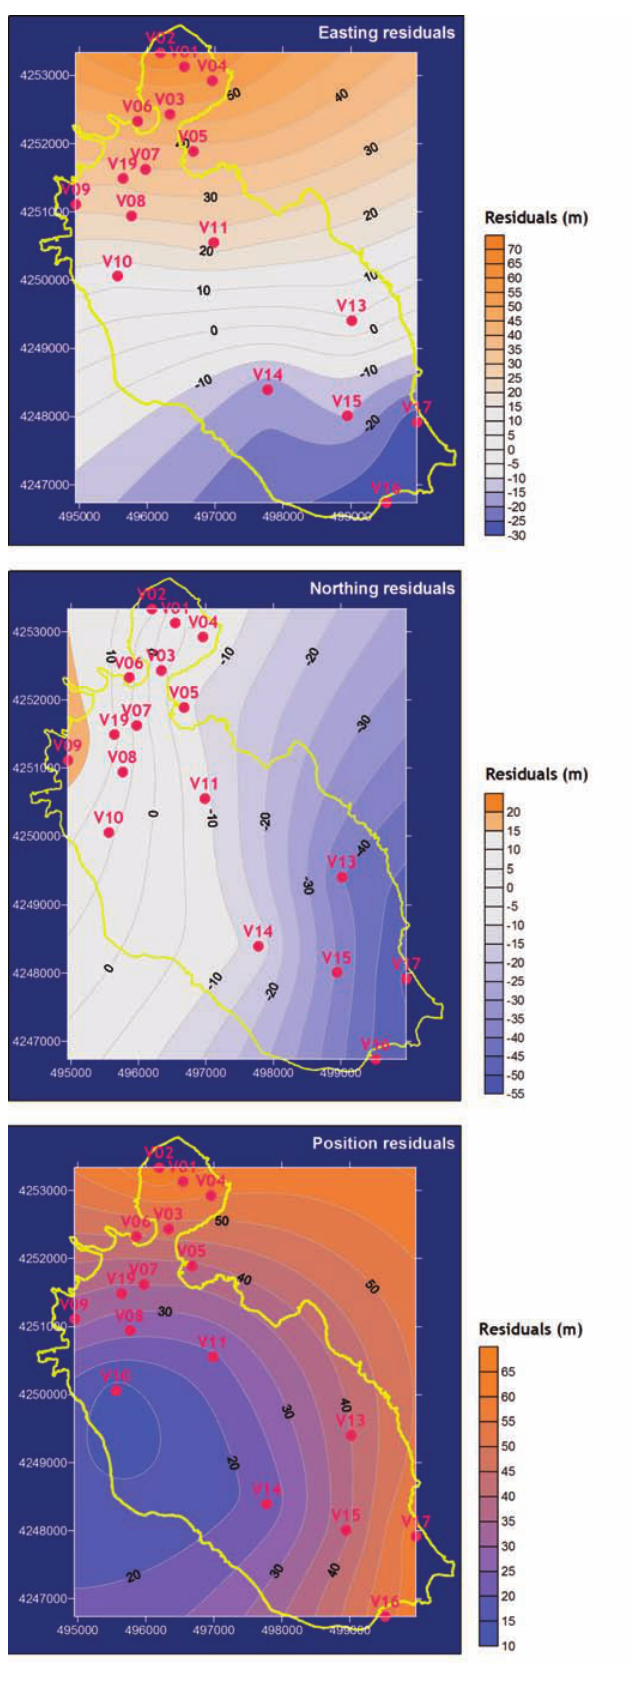
Figure 2. Positions of the GPS points acquired during the July 2008 survey at Vulcano Island (V01-V17; red circles). Gray lines, main roads; black polygons, buildings; colored shaded relief, the La Fossa cone.